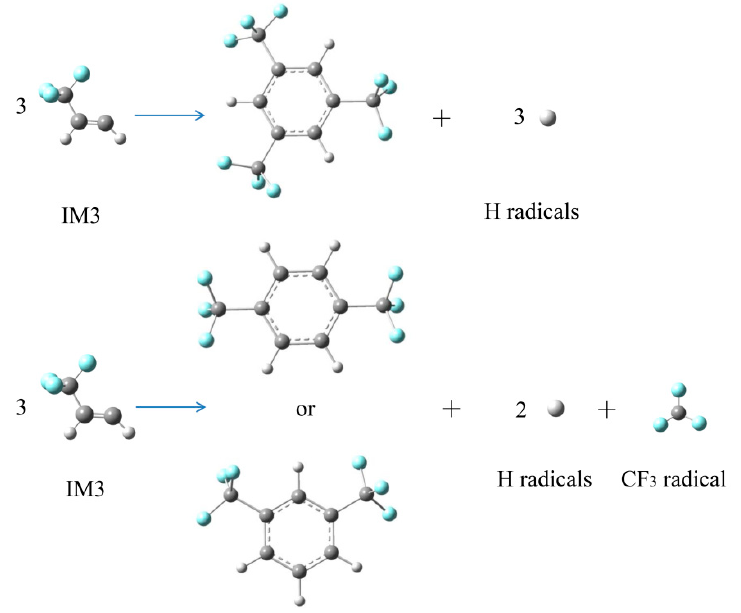
Figure 19. Possible reaction pathways of three polymers formation. C, H and F atoms are represented with black, gray and blue balls, respectively.